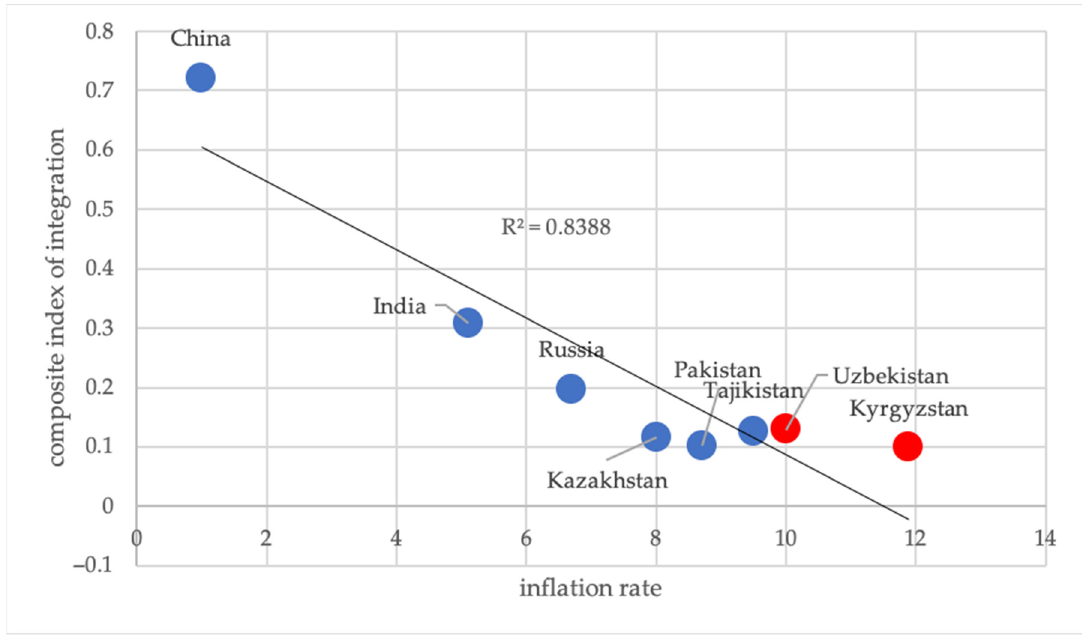
Figure 1. Dependence of inflation and the level of integration of countries into the world system.